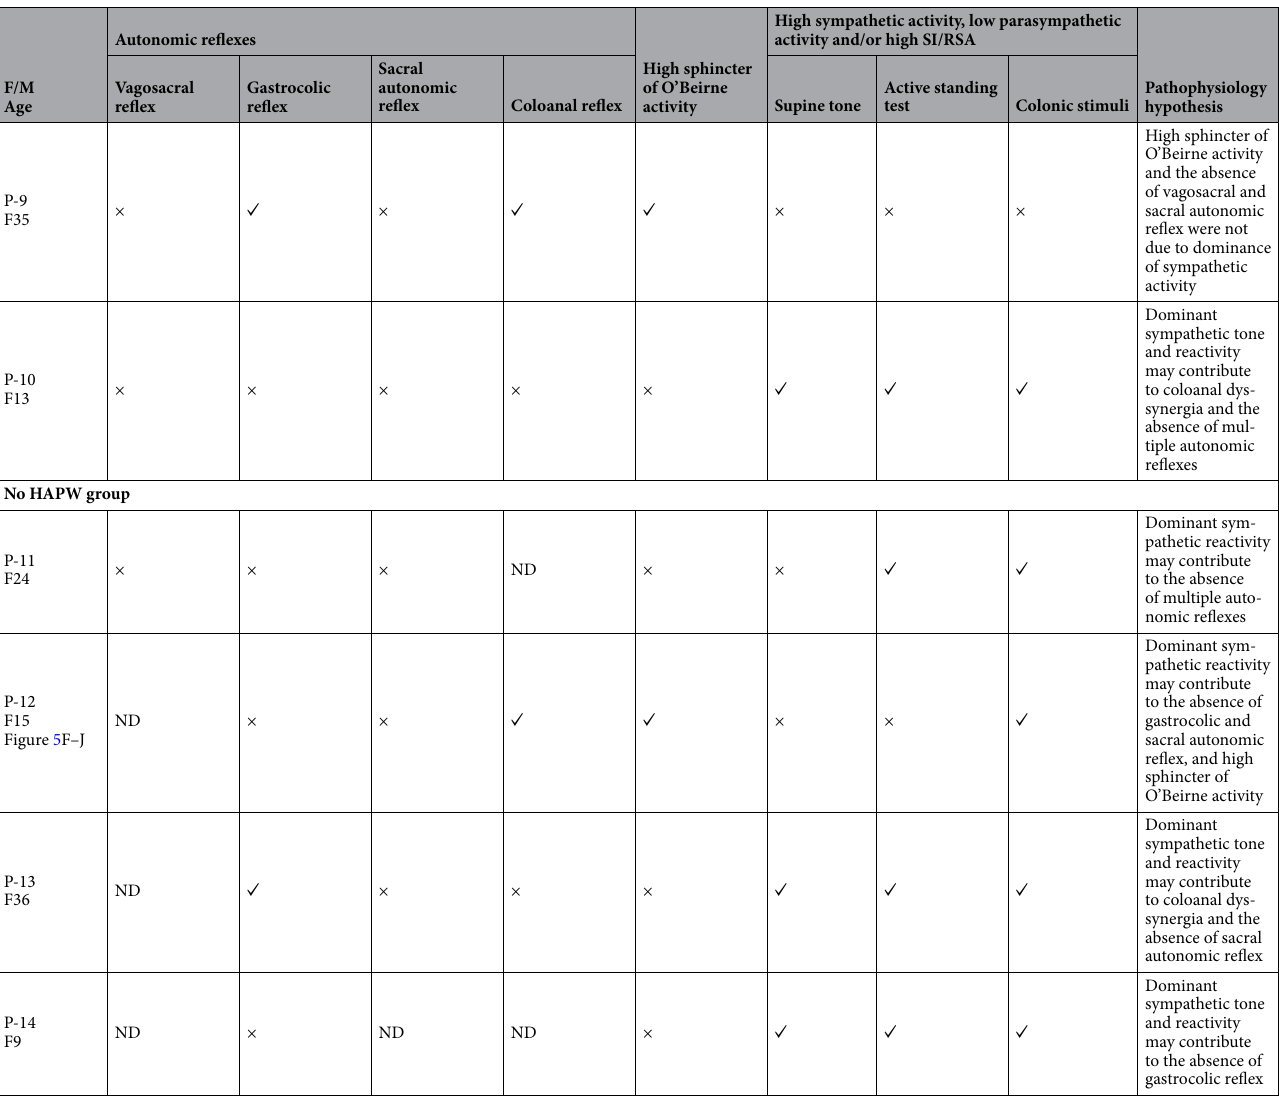
Table 3. Presence of autonomic reflexes, high sphincter of O’Beirne activity, and autonomic dysfunction in individual patients. ND: Not determined due to catheter position for vagosacral reflex, or lack of